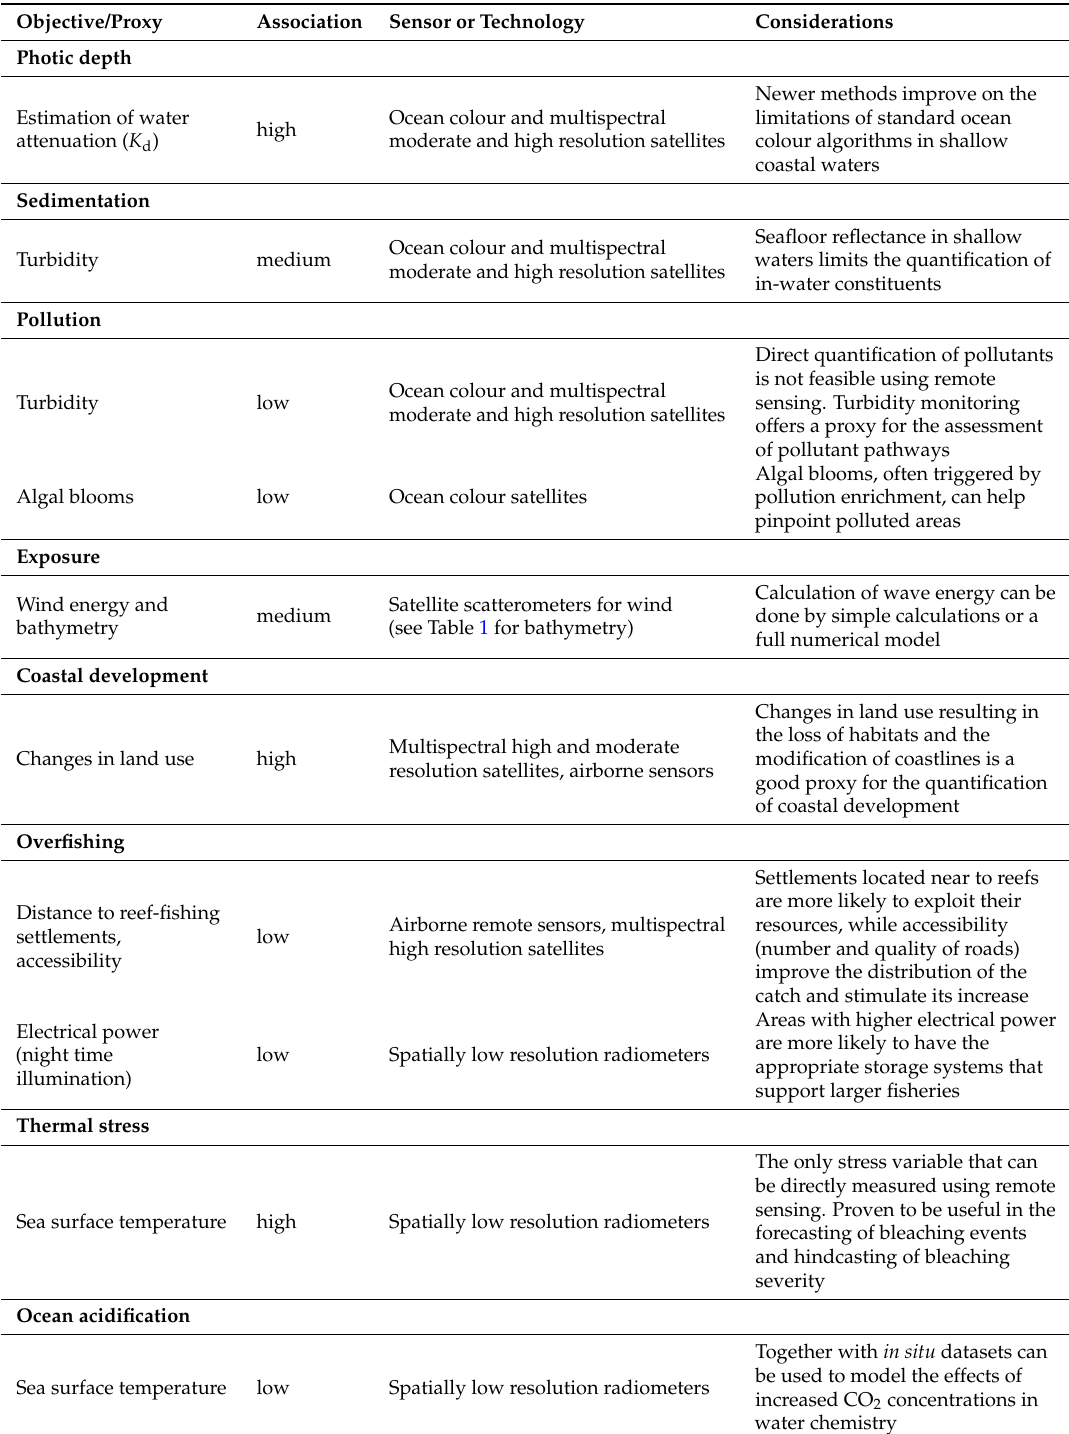
Table 2. Capability for evaluation of environmental factors by remote